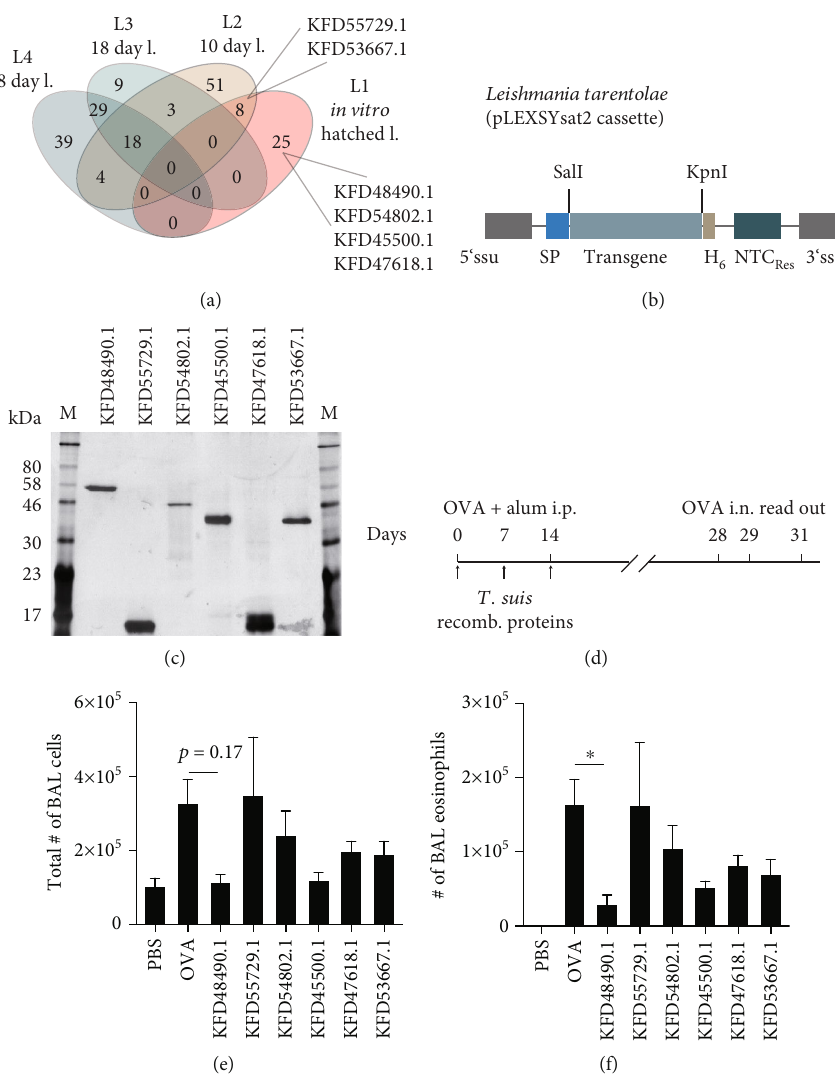
Figure 1: T. suis L1 ES proteins are highly stage-speci fi c, and candidates reduce allergic airway hyperreactivity when recombinantly expressed and applied. (a) Protein ID counts resulting from proteomic MS-based analysis (see Supplementary Table S1) were compared across the proteomic datasets of T. suis L1, L2, L3, and L4 ES proteins. Shown are protein IDs selected for recombinant expression. (b) Expression cassette of LEXSY eukaryotic expression system illustrating positioning of the export signal peptide that mediates secretion (SP), the selection antibiotic (nourseothricin, NTC), and the His -tag for puri fi cation (H ). The cassette was integrated into the L. 6 6 tarentolae genome. (c) Silver-stained SDS/PAGE gel of recombinantly expressed T. suis L1 proteins. (d) Experimental setup of acute ovalbumin- (OVA-) induced allergic airway hyperreactivity model and treatment regimen with recombinant T. suis proteins. Animals were OVA-sensitized on days 0 and 14 and challenged with OVA intranasally on days 28 and 29. BAL fl uid was collected from pretreated or untreated animals at day 31. (e) Total number of cellular in fi ltrates in BAL fl uid. Shown are nonallergic mice (PBS controls), untreated allergic mice (OVA), and treatments with recombinant T. suis proteins indicated by GenBank IDs. (f) Numbers of eosinophils in BAL fl uid detected by di ff erential cell counts of cytospin preparations stained with Di ff -Quick over the di ff erent treatment groups. Data shown are mean + SEM of n = 5 – 10 animals from 2 separate experiments. Statistically signi fi cant di ff erences were determined using a Kruskal-Wallis test (Dunn ’ s multiple comparisons test) and are indicated, ∗ p ≤ 0 : 05